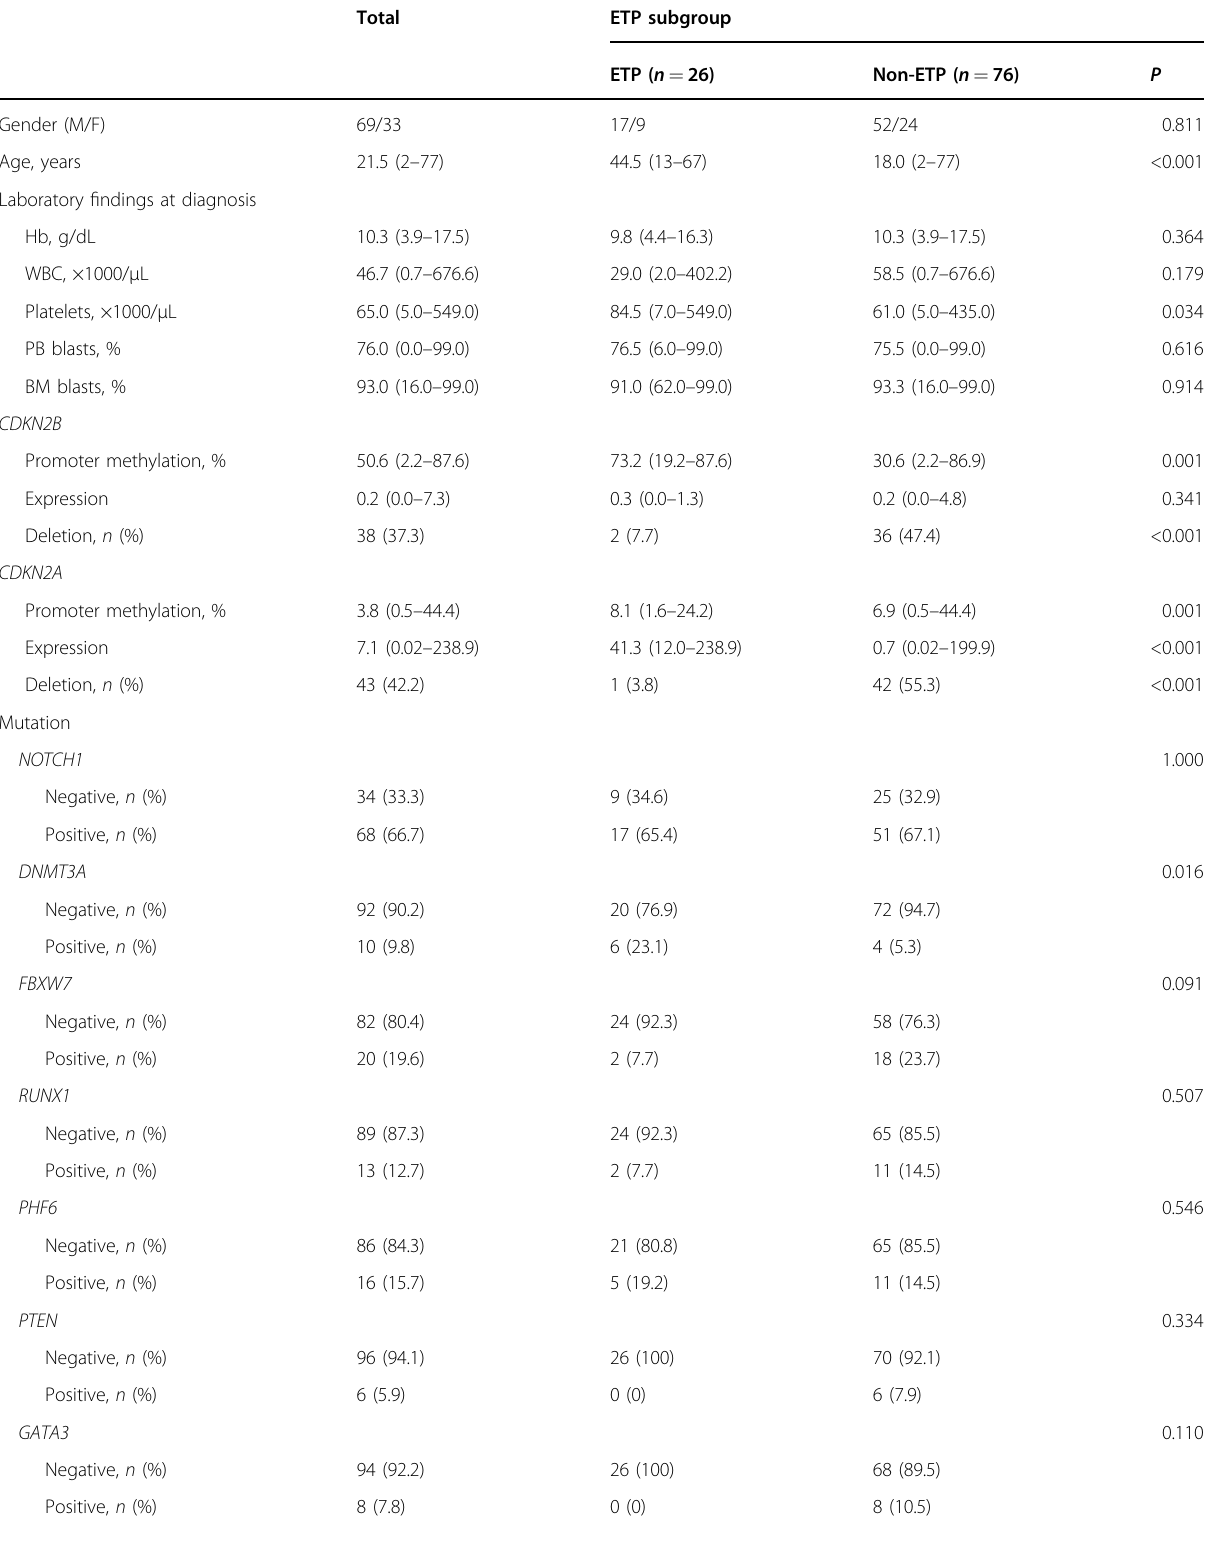
Table 1 Characteristics and outcome of 102 T-ALL patients according to the ETP